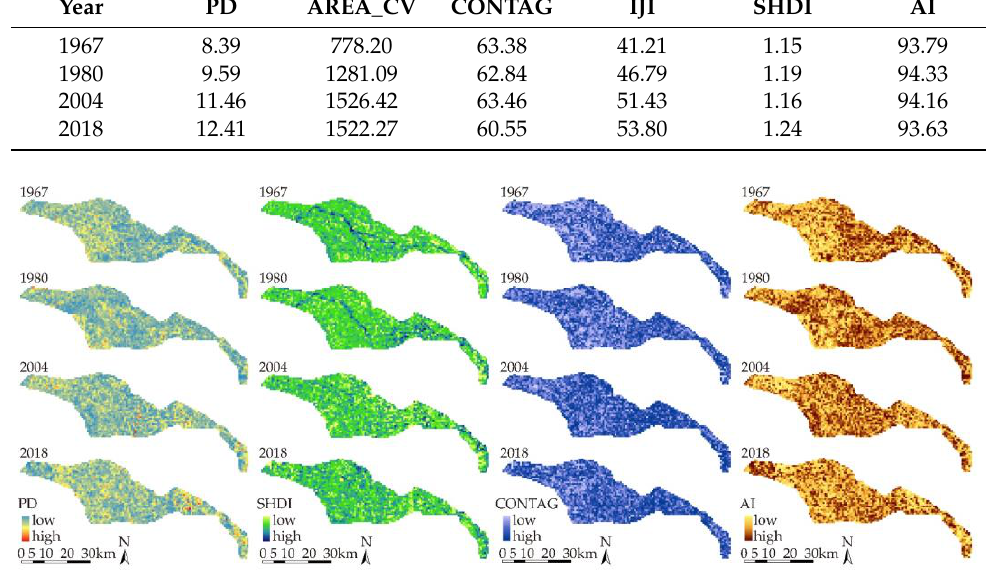
Figure 5. Landscape pattern index